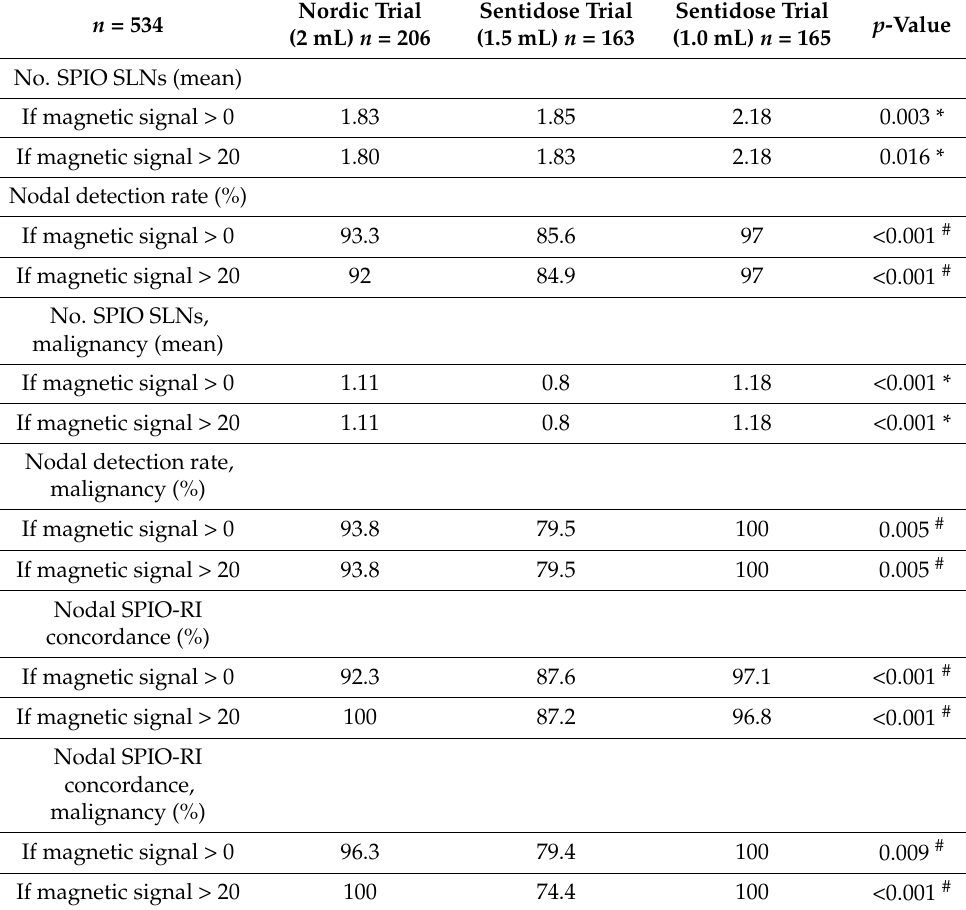
Table 3. Sentinel lymph node identification—per